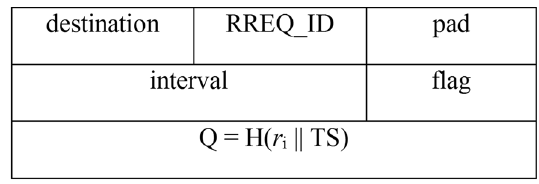
Figure 7. RREQ Packet.